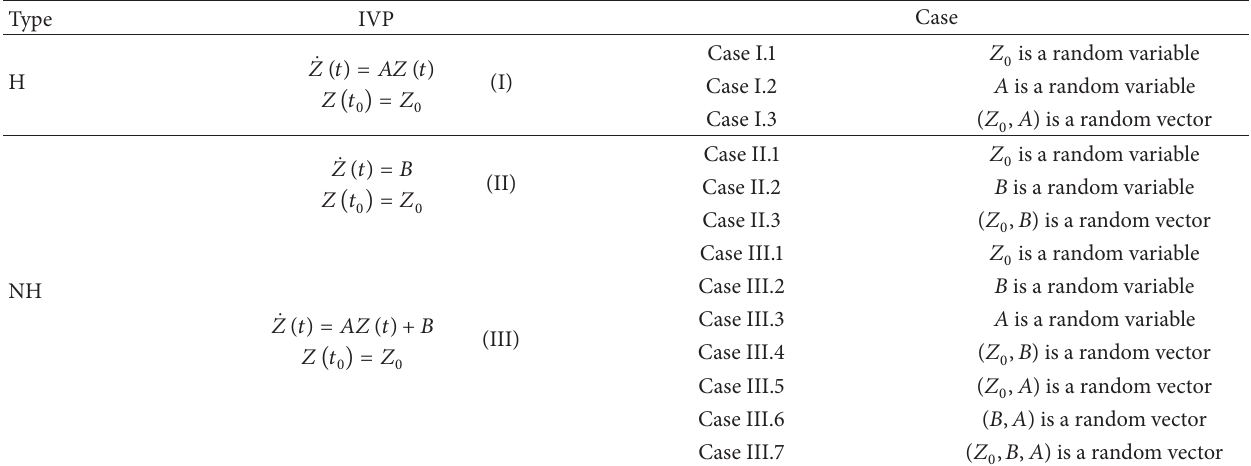
Table 1: List of the thirteen different cases considered to perform the full study depending on whether the IVP is homogeneous (H) or non- homogeneous (NH) and the form that uncertainty is considered into the problem: just through one RV: 𝑍 0 , 𝐵 , or 𝐴 (Cases I-II-III.1, I-II-III.2, and III.3), two RVs: ( 𝑍 0 ,𝐵 ), ( 𝑍 0 , 𝐴 ), or ( 𝐵,𝐴 ) (Cases I-II.3 and III.4-5-6), and the three involved RVs: ( 𝑍 0 ,𝐵,𝐴 ) (Case III.7). Type IVP Case